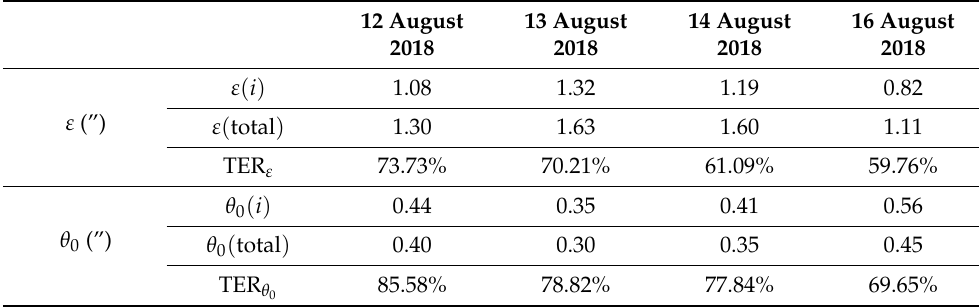
Table 2. The contribution of seeing ( ε ) and isoplanatic angle ( θ 0 ) from the range of 10–20 km to total height